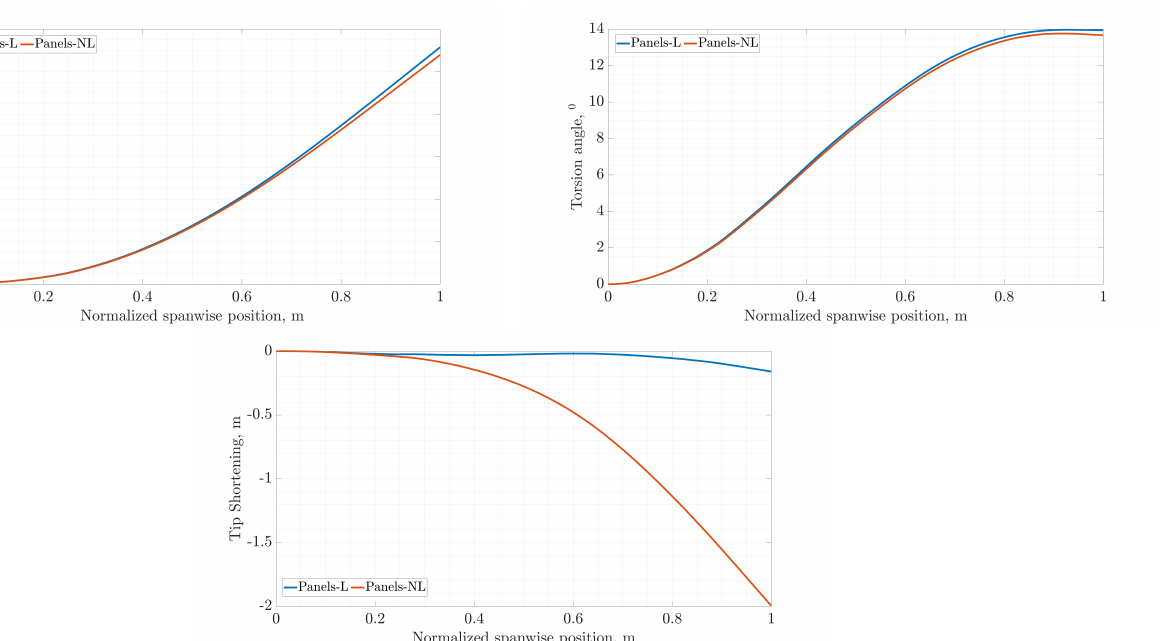
Figure 11. Deflection, torsion angle and tip shortening comparison between linear and nonlinear structural response of the uCRM-13.5 wing.